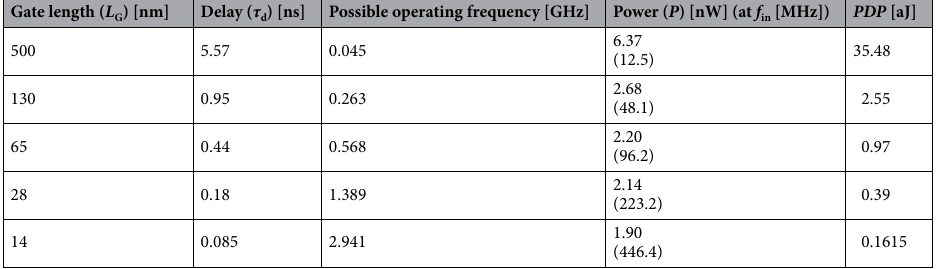
Table 1. Power and delay time according to gate length scaling.